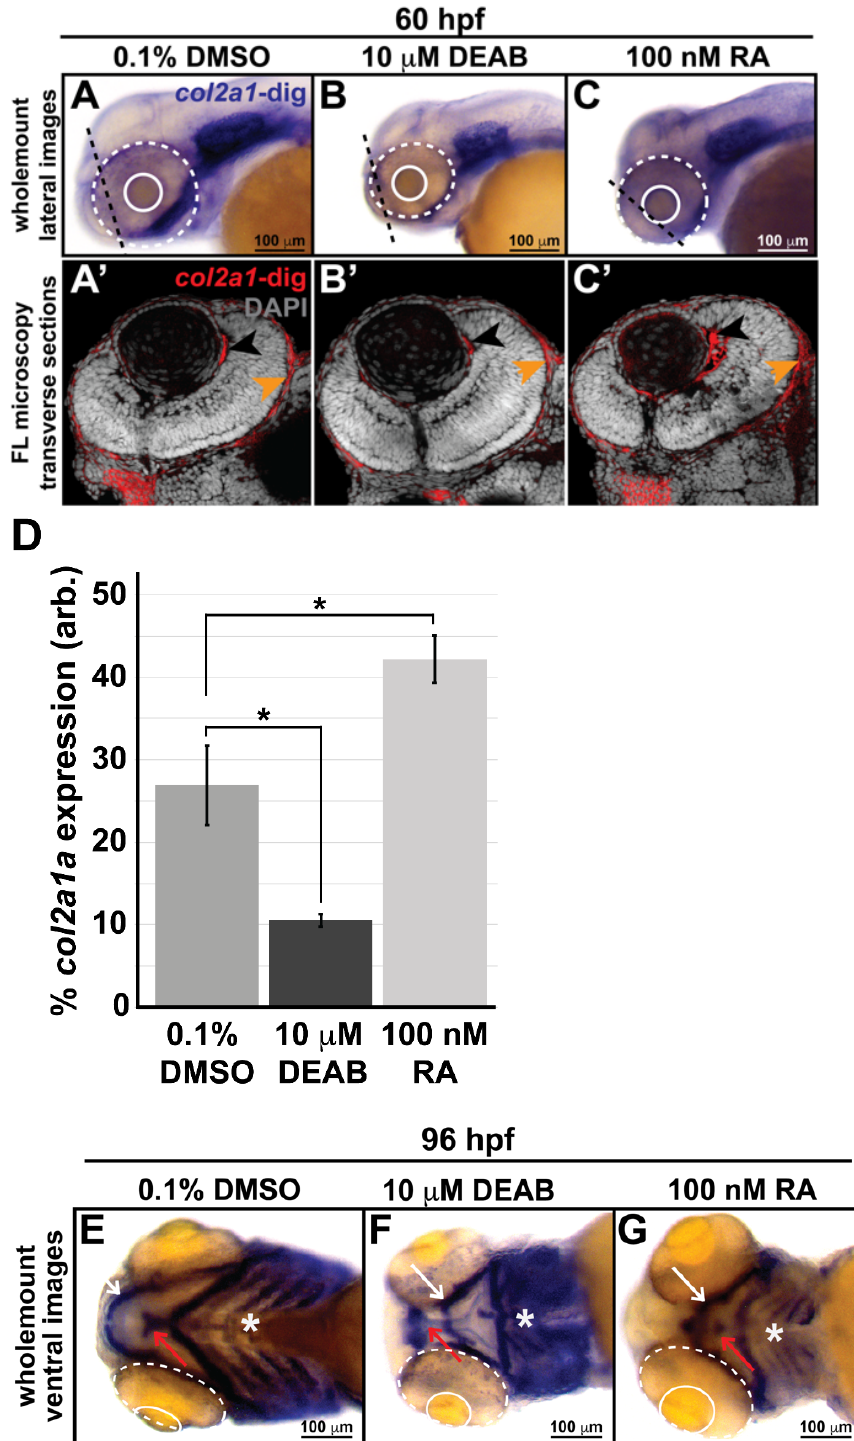
Figure 2. Retinoic acid regulates col2a1a expression in the ocular neural crest. Treatment with 10 mM DEAB, a selective pan-aldehyde dehydrogenase inhibitor, and 100 nM RA effectively decreased and increased, respectively, ocular col2a1a expression in WT Casper zebrafish embryos compared with their DMSO control-treated counterparts. Wholemount in situ analysis was performed using a chro- mogenic (blue) colorimetric assay (Vector Blue Substrate Kit, Vector Laboratories). Lateral images ( A – C ) at 60 hpf show the teratogenic effects of pharmacological insult on the ocular development of the treated embryos. The solid and dashed circles highlight the effect on eye size. The black dashed lines indicate the orientation of the plane of section, which passes perpendicular to the spinal column and extends in the rostral-caudal direction. FL microscopy analysis of transverse cephalic sections of the treated embryos at 60 hpf obtained after wholemount colorimetric in situ analysis developed using a fluorescent (Far Red/Cy5) substrate (Vector Blue Substrate Kit, Vector Laborato- ries) ( A’ – C’ ) show the effects of pharmacological insult on the anterior segment within the develop- ing eye. The black arrowhead highlights col2a1a expression in the hyaloid vasculature and the or- ange arrowhead highlights col2a1a expression in the sclera/periocular mesenchyme. Quantification of these effects ( D ) shows that DEAB significantly decreased col2a1a expression, while RA signifi- cantly increased col2a1a expression. *, p -value < 0.05. Ventral images ( E , F,G ) of wholemount in situ analysis at 90 hpf show the teratogenic effects of pharmacological insult on the ocular and craniofa- cial development of treated embryos. The solid and dashed circles highlight the effect on eye size. The white (Meckel’s cartilage development) and red (basihyal development) arrows highlight the effects on jaw development. The asterisks highlight the areas of pharyngeal arch development.